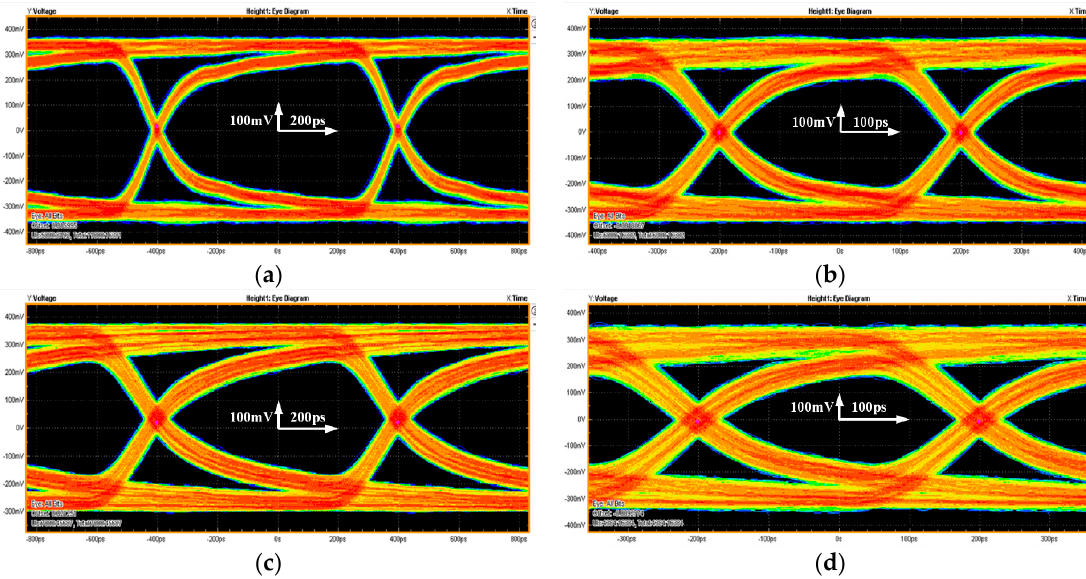
Figure 12. Measured output eye diagrams for different data rates ( a ) 1.25 Gbps of single lane; ( b ) 2.5 Gbps of single lane ( c ) 1.25 Gbps of multi-lane ( d ) 2.5 Gbps of multi-lane.